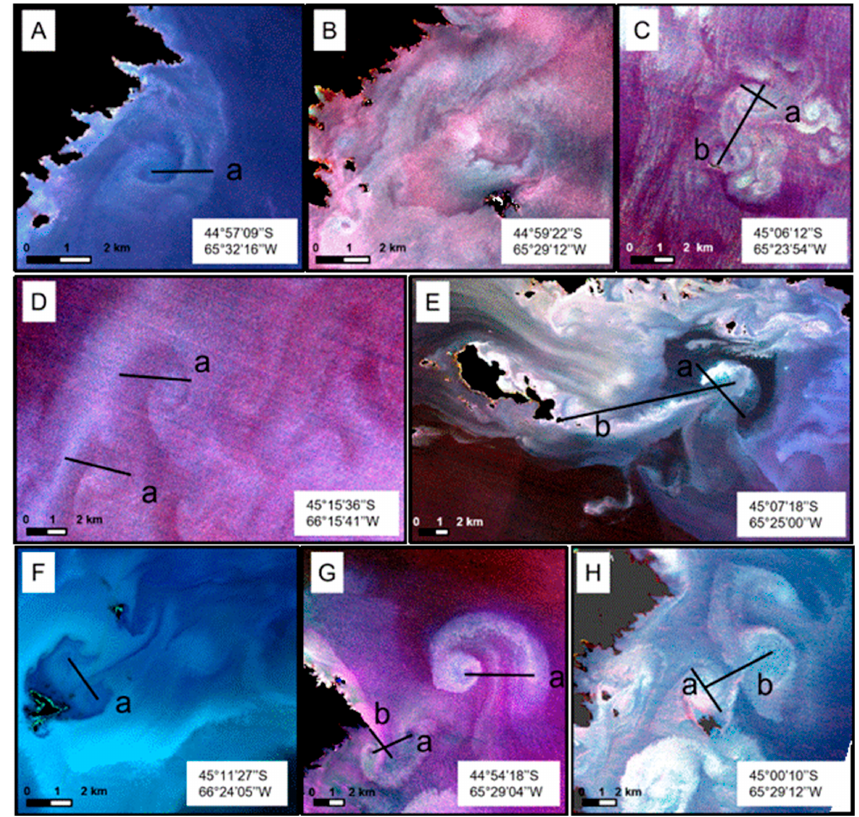
Figure 2. ( A ) Isolated cyclonic Eddy, ( B ) isolated anticyclonic Eddy, ( C ) von Karman vortex street ( D ) spiral eddies of the open ocean, ( E ) mushroom-like currents with shed, ( F ) eddies behind the islands, ( G ) double mushroom-like currents, ( H ) associated eddies. The black lines indicate how the structures were measured and show (a) eddy width, (b) wavelength of the eddies in ( C , H ); (a) cap and (b) stem of mushroom-like patterns in ( E , G ) .